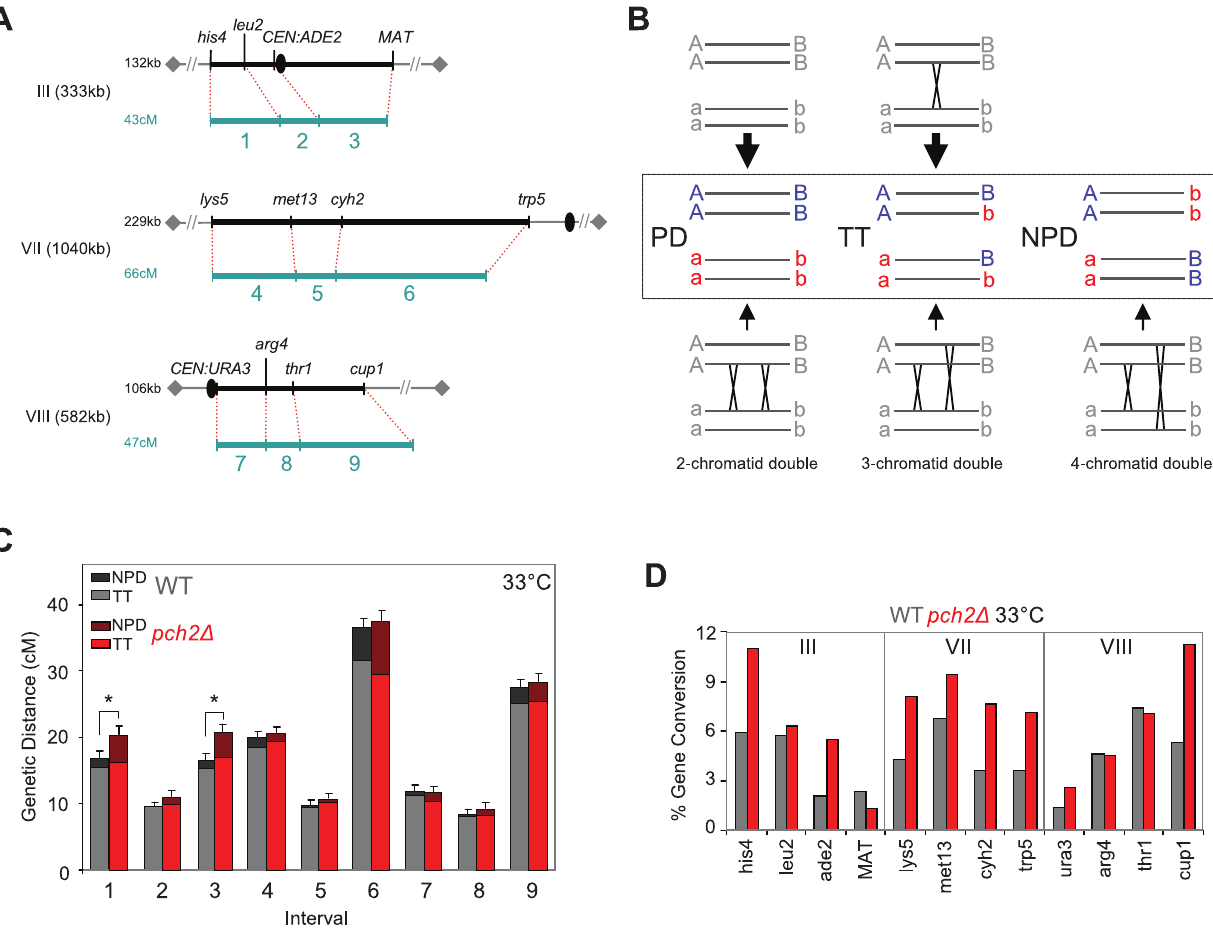
Figure 5. Genetic map distances in WT and pch2 D determined by tetrad analysis at 33 u C. (A) Test intervals on chromosomes III, VII, and VIII. Marker order, physical (kb) and genetic sizes (cM) of surveyed chromosome regions are shown. Ovals indicate centromeres; diamonds represent telomeres. Intervals are referred to by numbers 1–9 throughout the text. (B) Classes of tetrads for a given interval and contributing crossover (CO) events. Parental ditype tetrads (PD), generated in the absence of COs, and tetratype tetrads (TT), generated when a single CO occurs, are predominant tetrad classes. Nonparental ditype tetrads (NPD) are generated exclusively by double COs involving all four chromatids. Double COs involving three chromatids produce TTs, and those involving two chromatids produce PDs. (C) Genetic distances determined for intervals 1–9 (see A) at 33 u C. Contributions of TTs and NPDs to map distances are indicated in different shades. Asterisks indicate significant differences between map distances in WT and pch2 D strains. Error bars represent standard errors (see also Table 1). (D) Frequencies of non-Mendelian segregation (=gene conversion) events (i.e. markers deviating from 2:2 segregation) in WT and pch2 D at 33 u C. Map distances derived from subset P are remarkably similar between WT and pch2 D , with only a single interval exhibiting a significant increase in pch2 D CO frequencies (interval 5 P6 ; Figure 6A, left panel). In contrast, map distances derived from subset N are strikingly different between WT and pch2 D (Figure 6A, right panel): In six out of 12 adjacent interval pairs, map distances are significantly increased in pch2 D compared to WT. Thus, Pch2 has no detectable effect on CO frequencies along an interval when the adjacent interval is parental, but suppresses CO formation in the same interval when the adjacent interval is recombinant. Notably, total map distance increases in intervals 1 and 3 in pch2 D can entirely be attributed to subset N tetrads, while map distances in subset P tetrads are indistinguishable between WT and pch2 D (Figure 5C; Figure 6A, left panel).